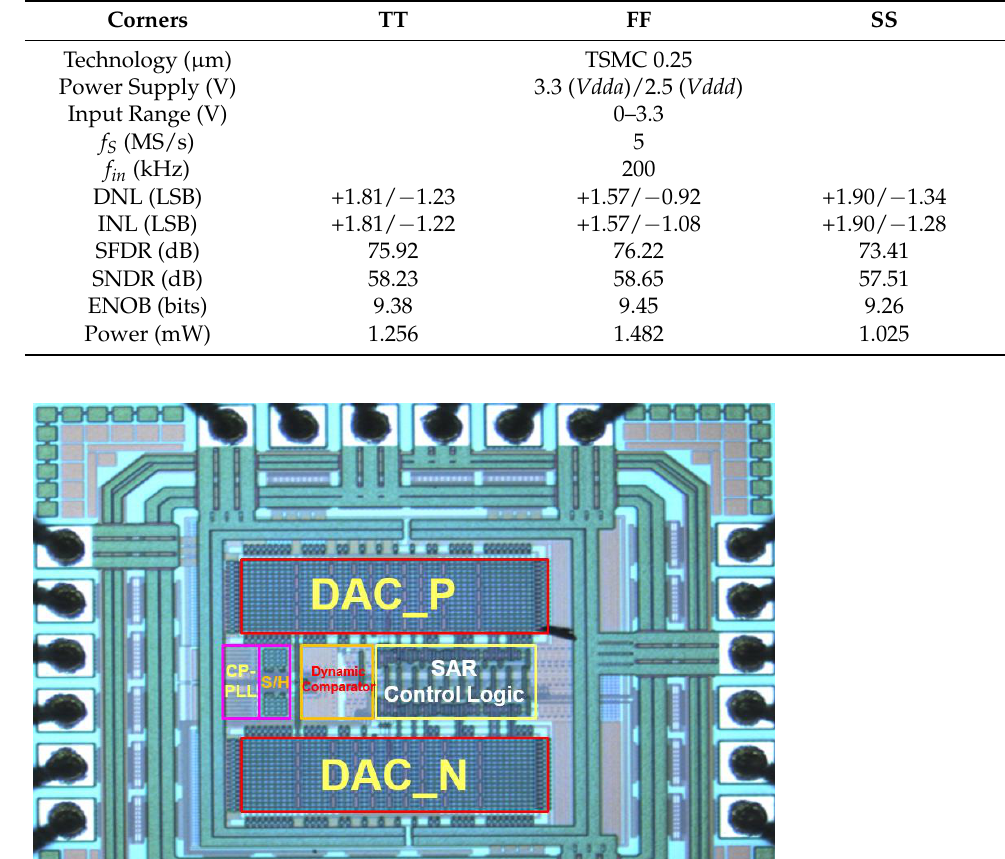
Figure 22. Chip microphotograph of the proposed PLL-SAR ADC.